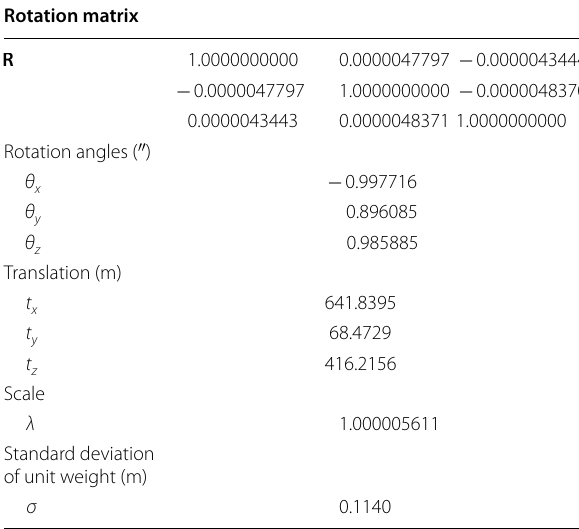
Table 4 Computed dual quaternion by ADQA Table 5 Calculated transformation parameters by ADQA, MPA, and